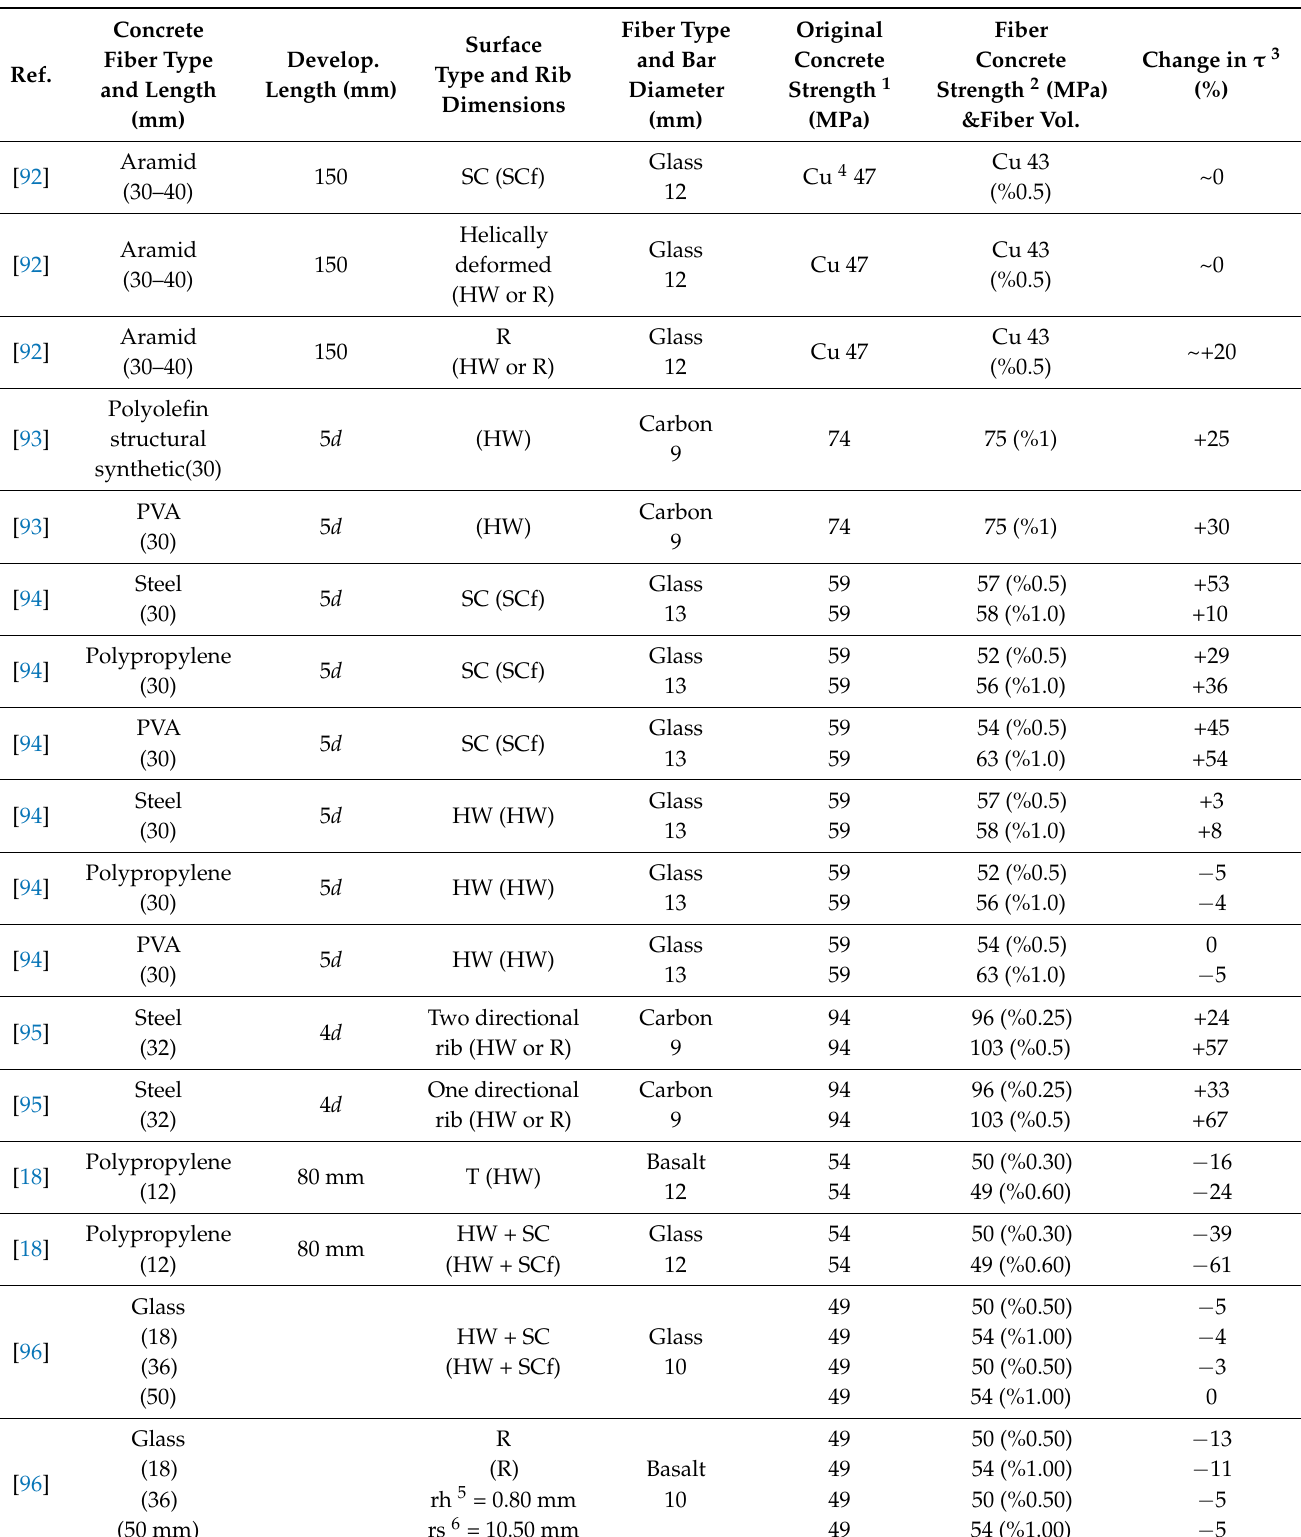
Table 7. Studies on the influence of fiber contribution on FRP–concrete bond